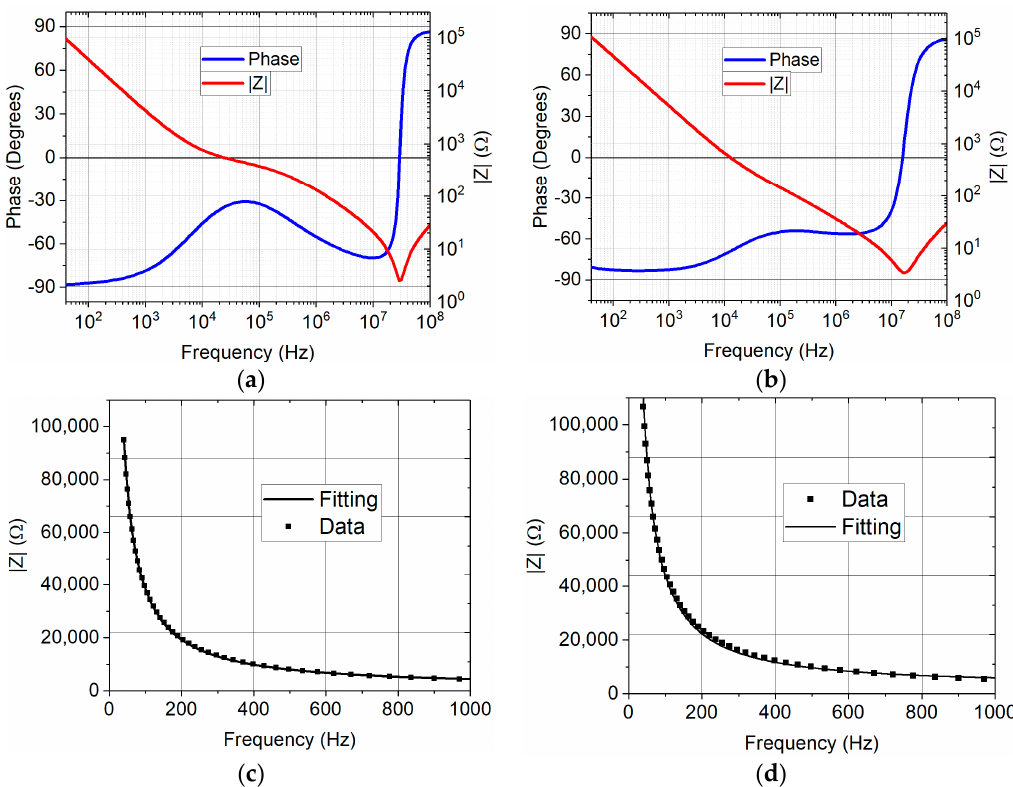
Figure 8. Module of impedance (| Z |) and phase curves as a function of frequency for the single dielectric layer ( a ) and triple dielectric layer ( b ) capacitors. Below, the impedance module data limited to the low-frequency range (from 40 up to 1000 Hz) and its fittings for the single dielectric layer ( c ) and triple dielectric layer capacitor ( d ), respectively, are represented.